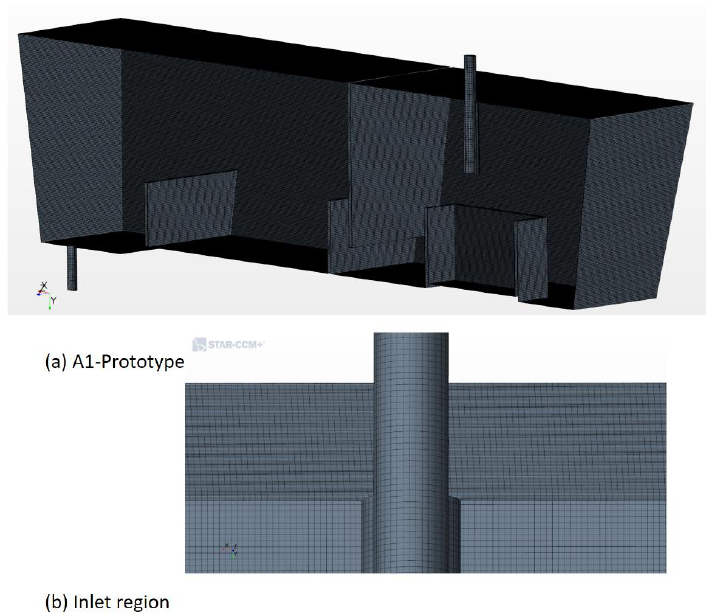
Figure 10. Computational domain and CFD mesh of single-strand tundish ( a ) A1-Prototype; ( b ) inlet region (zoom-in view).